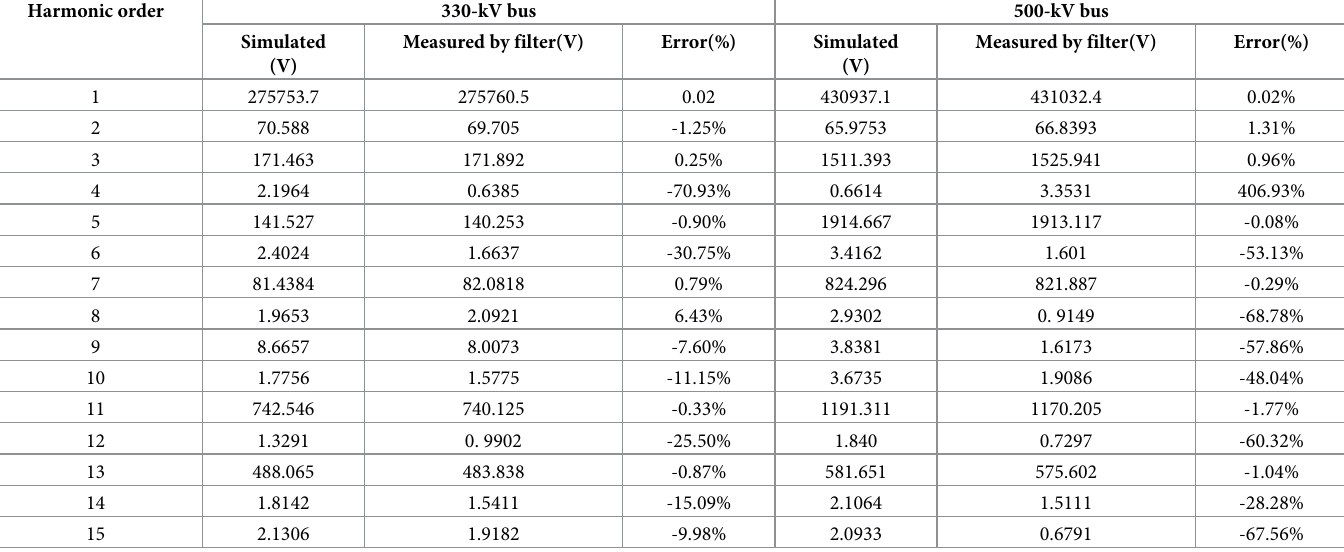
Table 12. Comparison of the amplitude of the individual harmonic